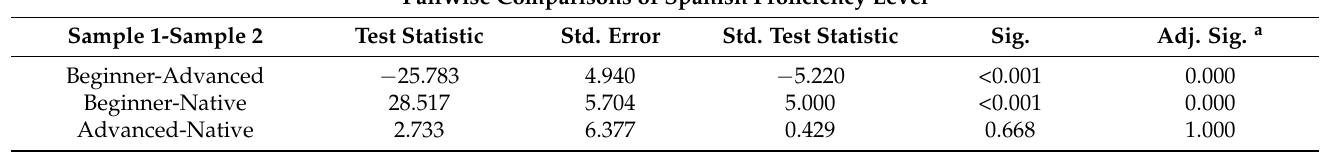
Table A4. Pairwise Comparisons table for Task